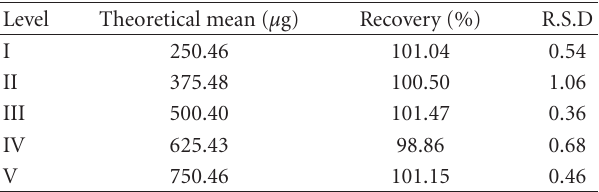
Figure 3: LOQ-LOD obtaining by plotting the area RSD (%) versus the CB13